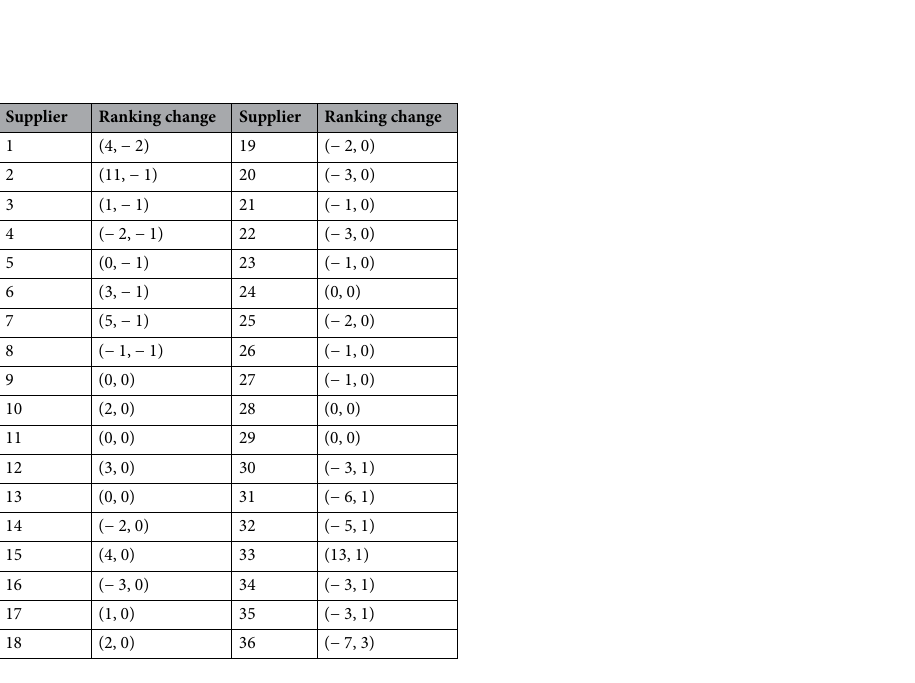
Table 4. The ranking changes of each